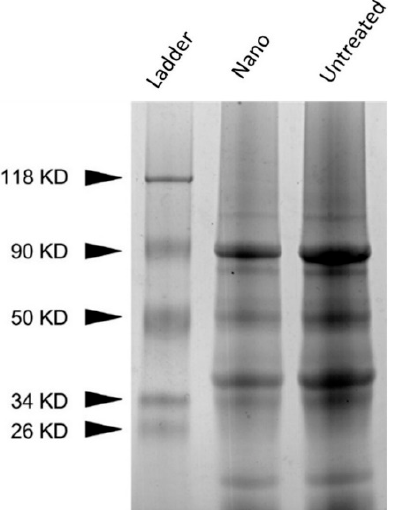
Figure 2. SDS-PAGE of UPP (untreated) and PPN (nano). Silver-stained gel.